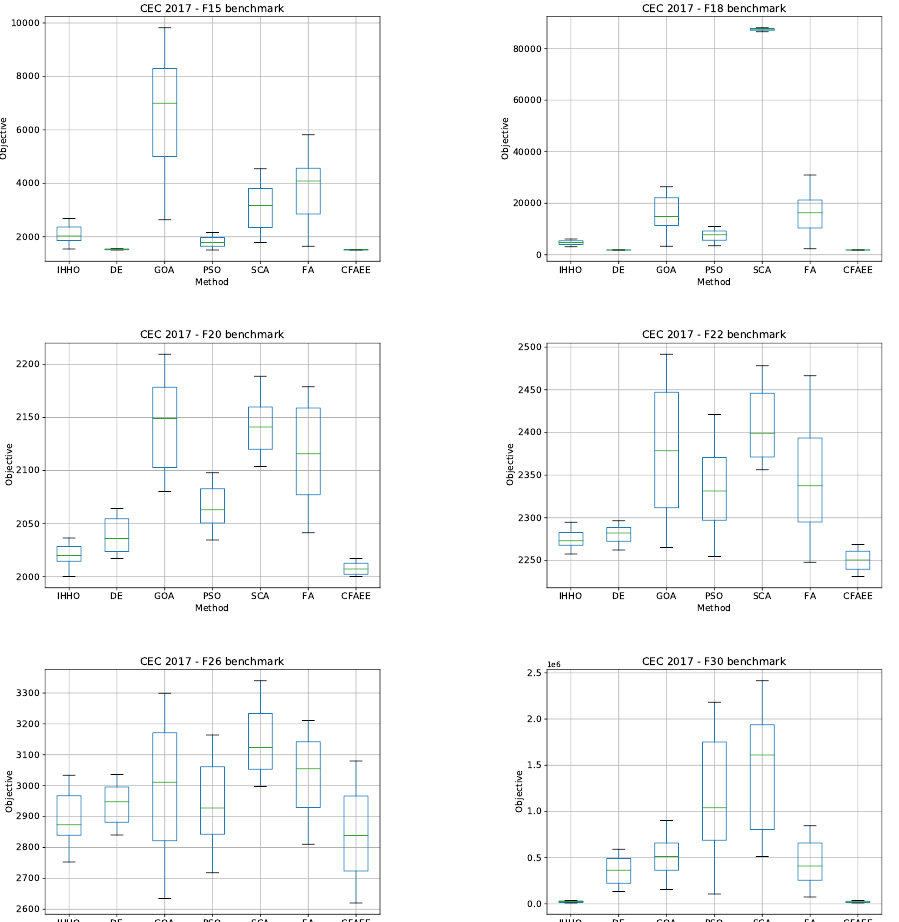
Figure 3. Dispersion of best results over runs for functions F15, F18, F20, F22, F26, F30 (Benchmark set